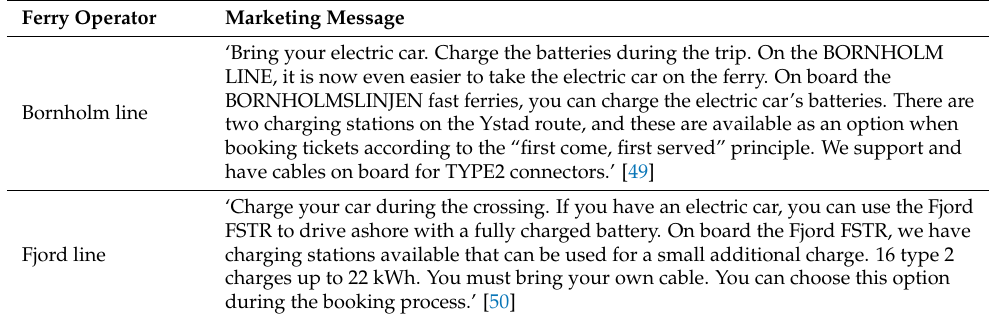
Table 4. Ferry operators’ marketing message for onboard charging.